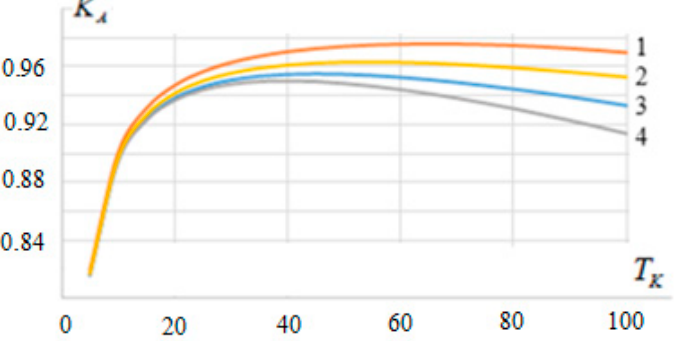
Figure 2. Dependences of the readiness coefficients on the periodicity of the control for various distribution laws: Rayleigh’s law (1), normal law (2), exponential law (3), and Weibull’s law (4).